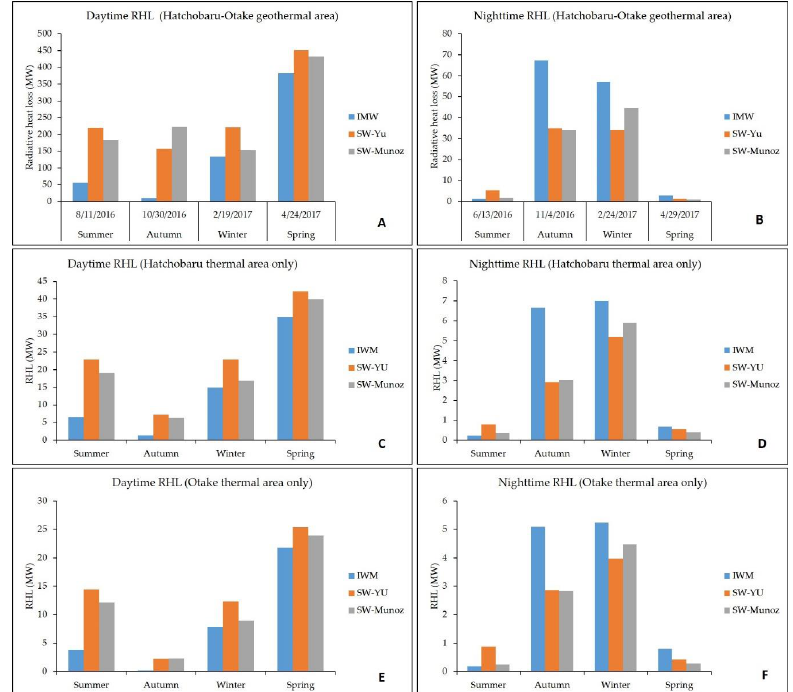
Figure 20. Total radiative heat loss from the study area for both the day- and night-time Landsat 8 images, calculated using all three methods of the LST estimation are shown as the Hatchobaru–Otake geothermal area as a whole ( A , B ), the Hatchobaru thermal area only ( C , D ), and the Otake thermal area ( E , F ). The Hatchobaru and Otake thermal area were selected based on the higher thermal anomaly, shown in Figure 13 as circles. IMW—improved mono-window algorithm; SW-Yu—split-window algorithm of Yu et al. [19]; SW-Muñoz—split-window algorithm of Jiménez-Muñoz et al. [20].